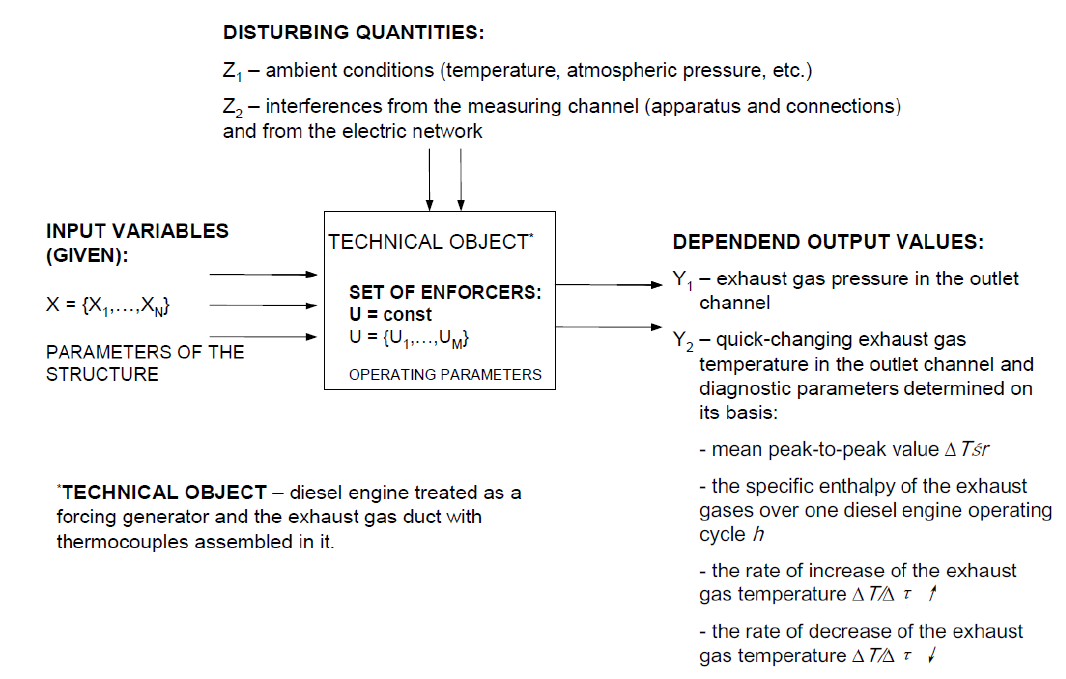
Fig. 3. Simplified physical model of a diagnostic subject for an elimination experimental test realized according to a randomized complete plan